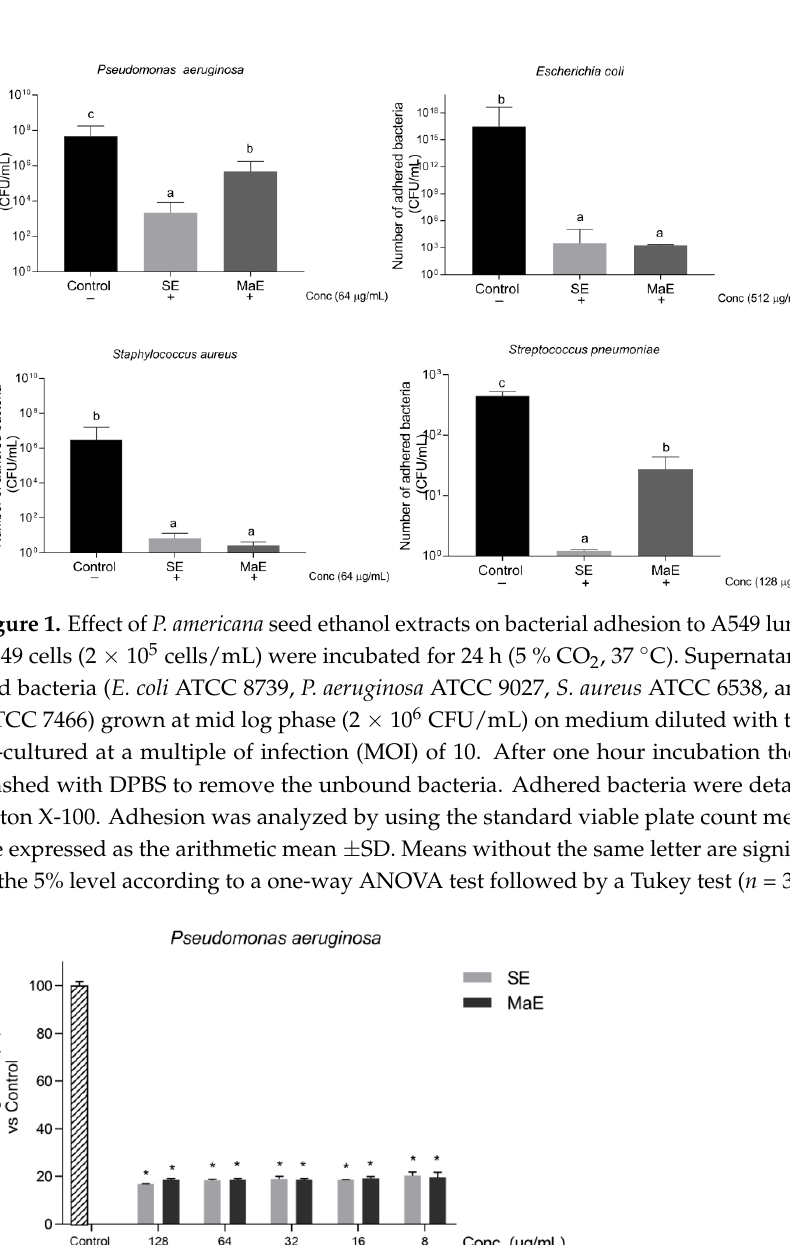
Figure 2. Inhibition of P. aeruginosa ATCC 9027 biofilm growth by P. americana seed ethanol extracts.